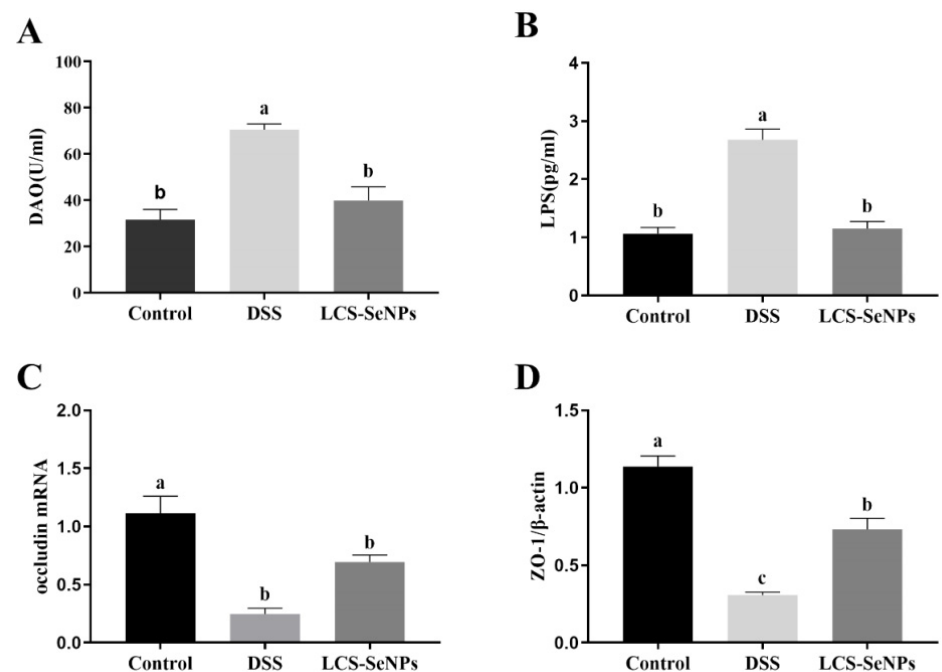
Figure 5. LCS-SeNPs altered intestinal permeability in DSS-induced colitis mice. The levels of DAO ( A ) and LPS ( B ) in serum; the mRNA expression levels of occludin ( C ) and ZO-1 ( D ) in colon tissue. Data are presented as mean ± SEM. In the same column values with different letters superscripts differ significantly ( p < 0.05).